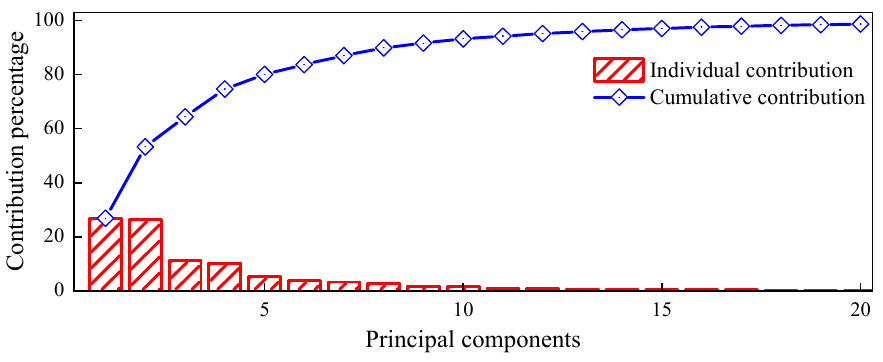
Figure 8. PCA results of images processed by the Sobel filter.